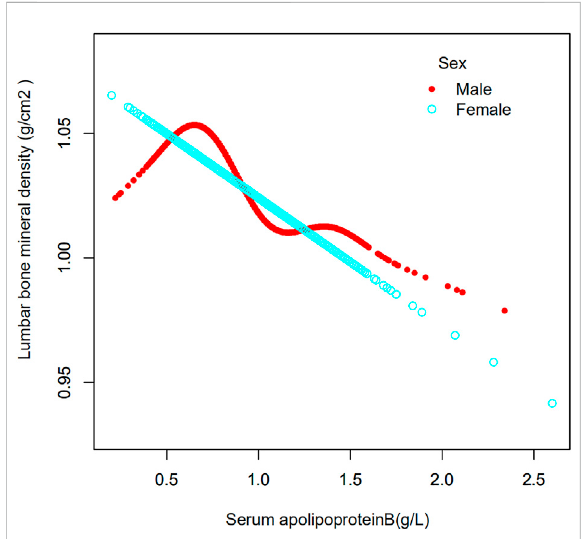
FIGURE 3 Association between serum apolipoprotein B concentrations and lumbar bone mineral density strati fi ed by sex. Age, race/ ethnicity, sex, vigorous recreational activities, smoked at least 100 cigarettes in life, income to poverty ratio, blood urea nitrogen, serum calcium, serum potassium, serum sodium, serum phosphorus, total protein, serum uric acid, body mass index were